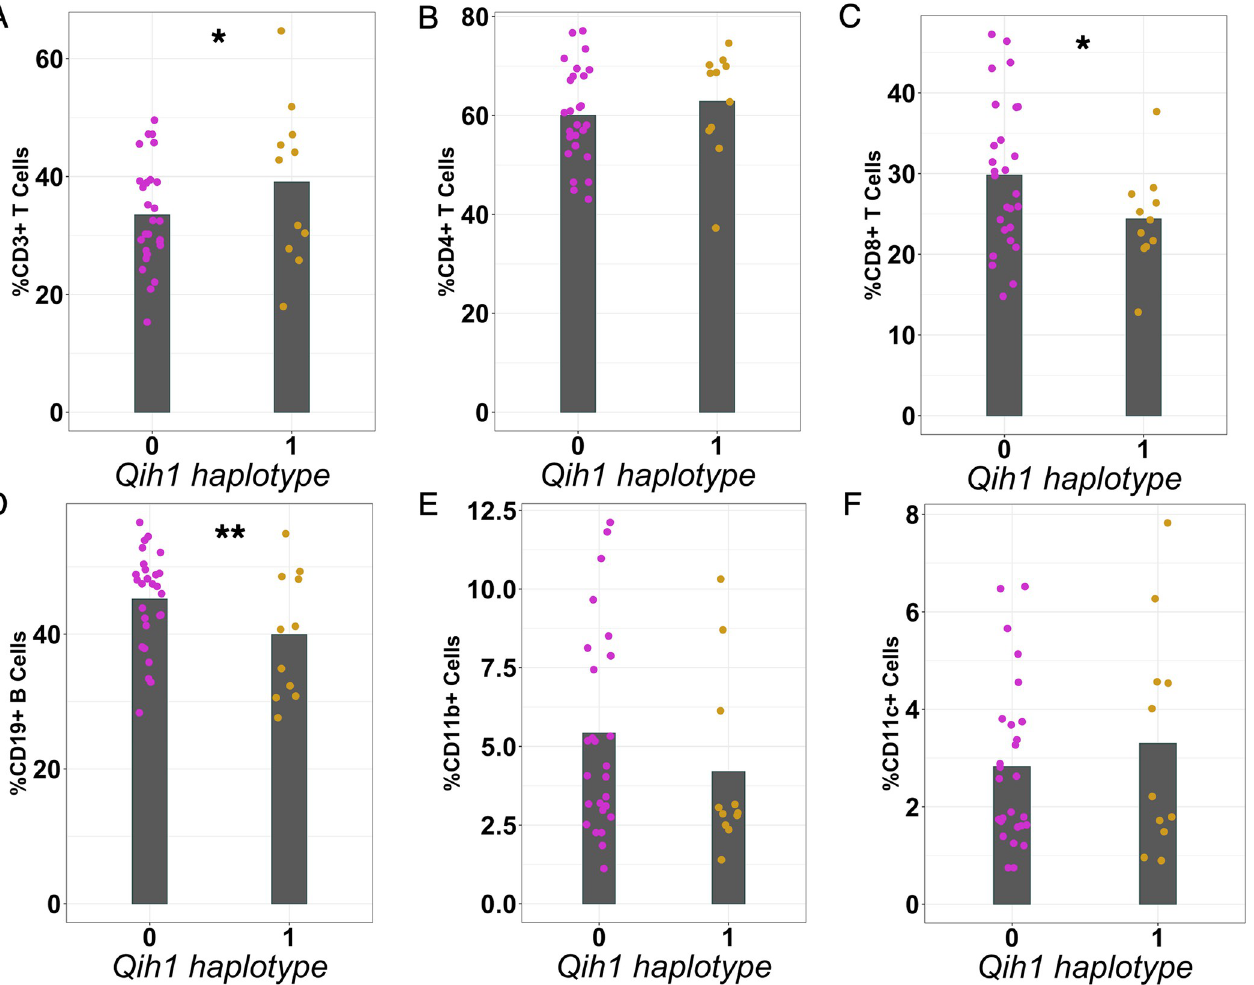
Fig 5. Qih1 shows broad effects on immune cell populations in the spleen. We assessed the relationship between B6, WSB, and CAST haplotypes ( Qih1 haplotype = 1) and (A) CD3 + T cells, (B) CD4 + T cells, (C) CD8 + T cells, (D) CD19 + B cells, (E) CD11b + cells, and (F) CD11c + cells in the spleen. Each point represents the mean value for each CC strain and the mean for each haplotype group on the x-axis is denoted by the grey crossbar. ( � p < 0.1, �� p < 0.05) p- values determined using nested linear model approach described in the